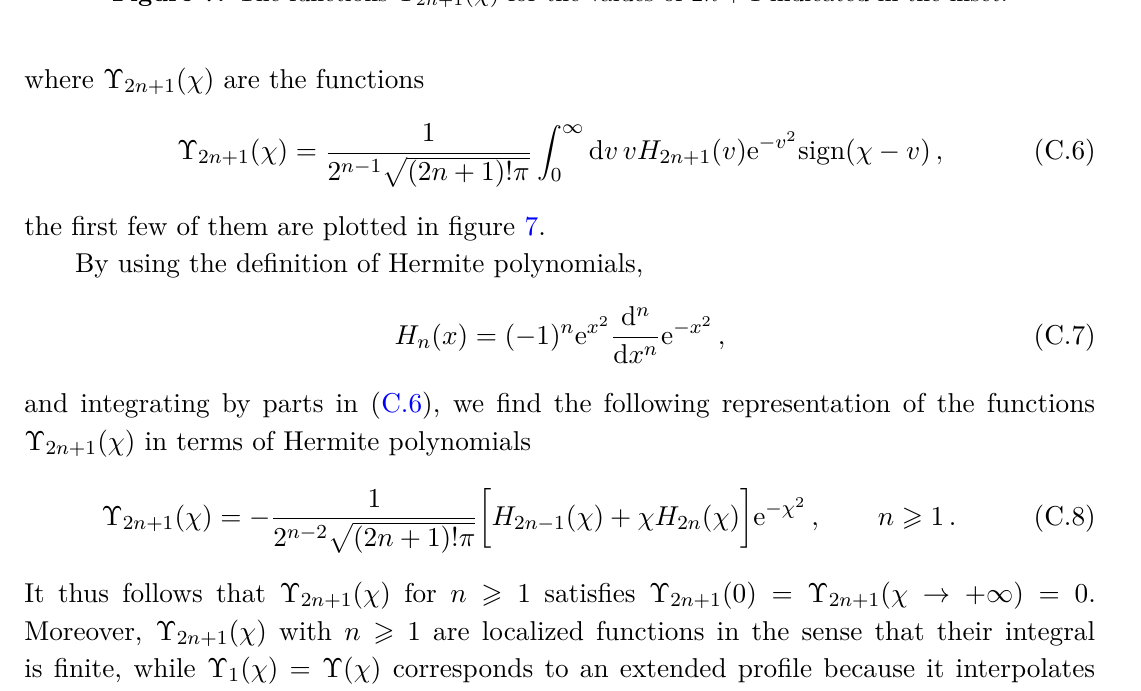
Figure 7. The functions Υ 2 n +1 ( χ ) for the values of 2 n + 1 indicated in the